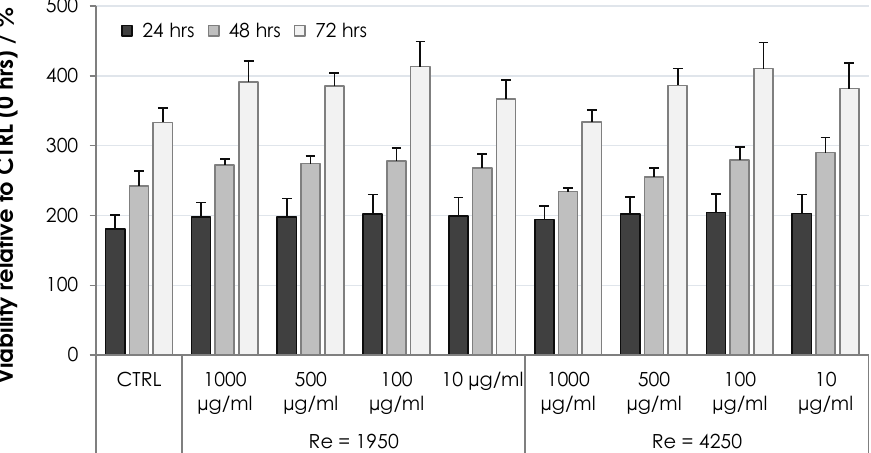
Figure 10. Viability of HaCaT cells subjected to dissolved HA textiles for 24, 48 and 72 h. Columns represent mean values and error bars the standard deviation.